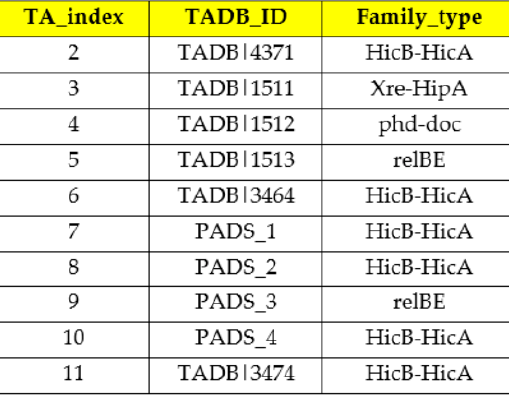
Figure 4. Clustered heatmap mapping the coverage of syntentic hits between each contig. Each cell is labeled by an index indicating the TA systems shared by each contig pair (table above). The color conventions show the coverage proportion between each contig pair; 1 means 100% coverage, and 0 indicates no synteny between corresponding contigs. The columns and row labels represent the isolate id, along with the contig number.